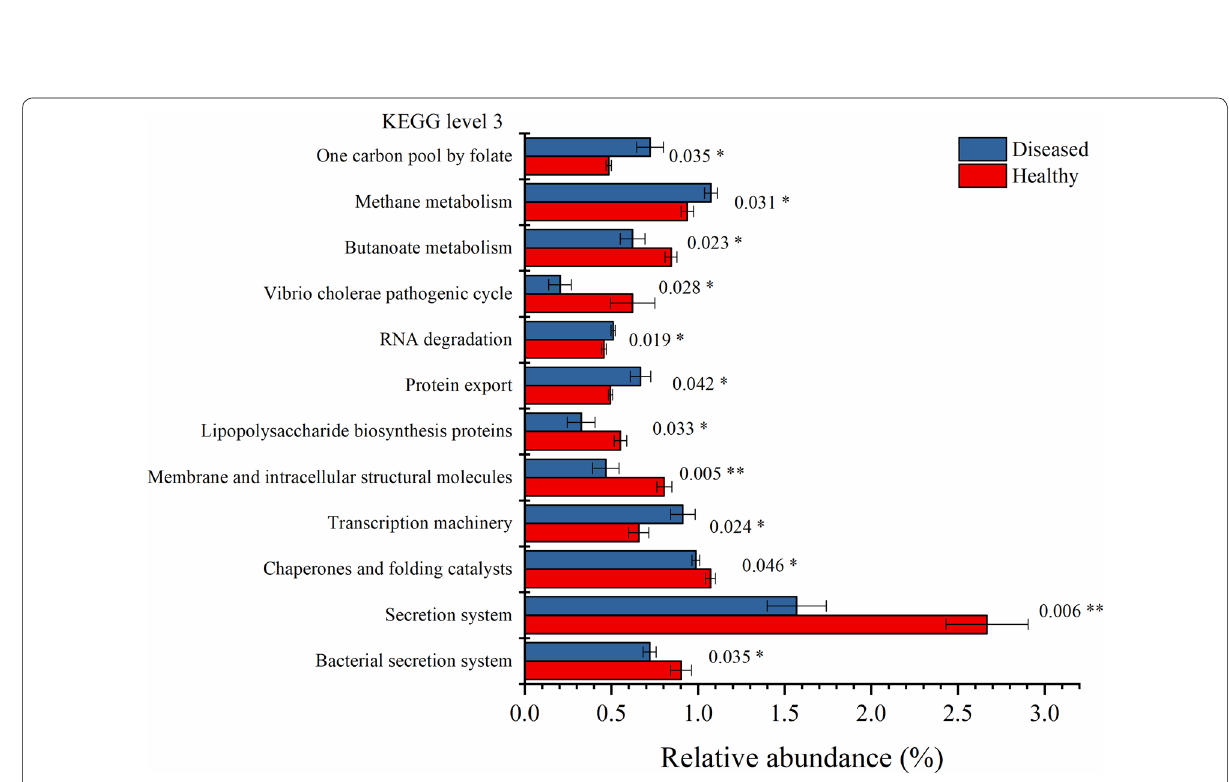
Fig. 5 Predicted functions of the intestinal microbiota that varies significantly at between the healthy and diseased crabs (* P < 0.05, ** P <